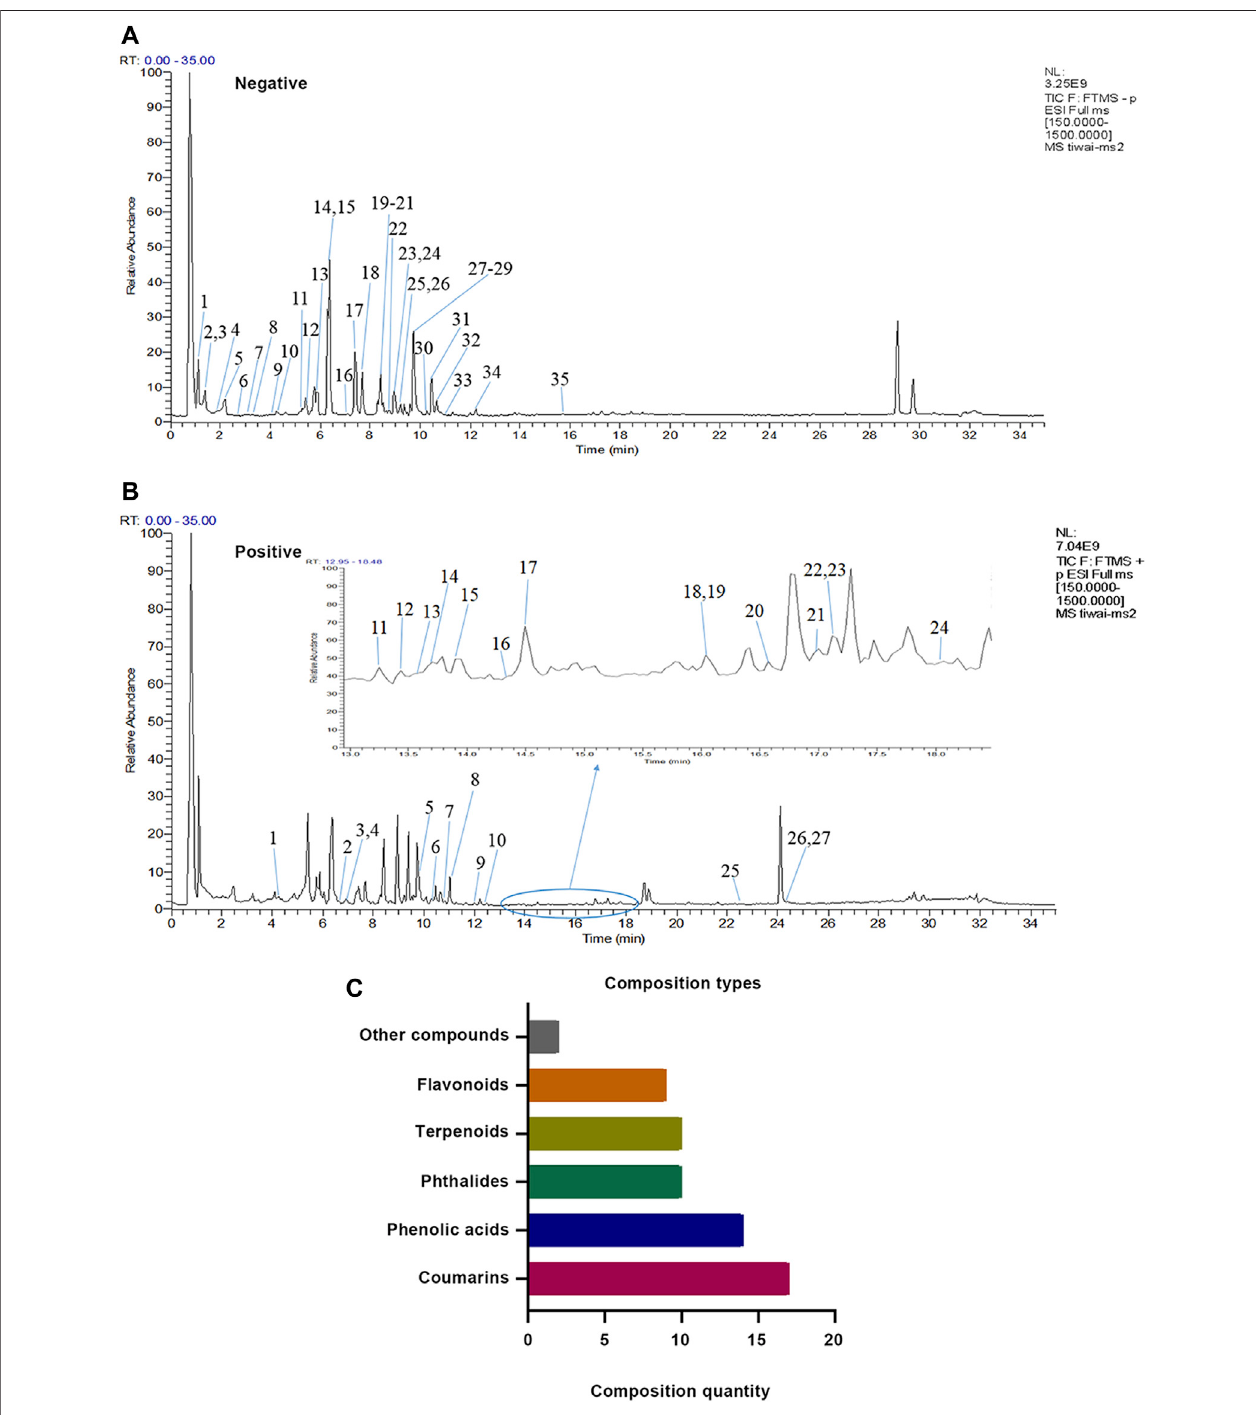
FIGURE1| Identi fi cationresultsofthemainchemicalcomponentsofXZRbyUHPLC-LTQ-OrbitrapMS. (A) Totalion fl owdiagramofXZRinanionmode(detailsof Nos. 1 – 35 are listed in Supplementary Table S1 ). (B) Total ion fl ow diagram of XZR in the positive ion mode (details of Nos. 1 – 27 are listed in Supplementary Table S2 ). (C) Identi fi cation of the main components in XZR. XZR, Xiongshao Zhitong Recipe.